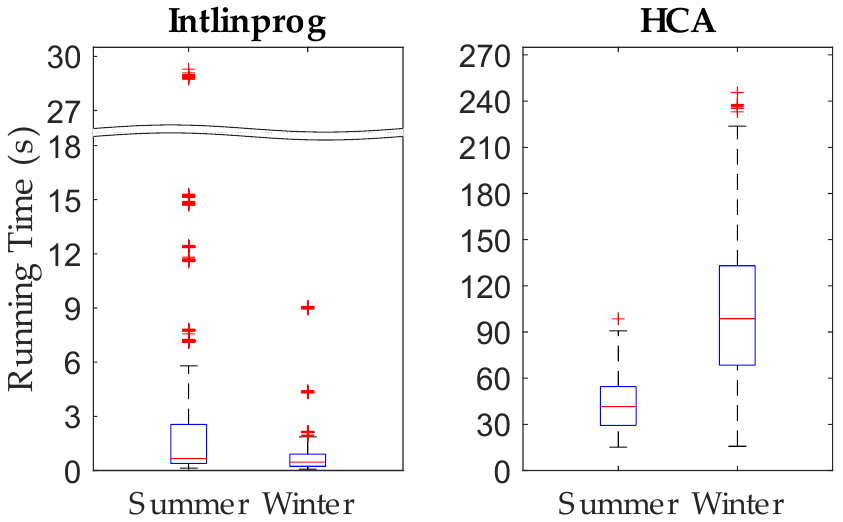
Figure 5. Running time durations of optimisation solvers intlinprog and the HCA registered when repeating winter and summer simulations twenty times. These repetitions are necessary to determine running time variability due to computer processing hierarchy. This study is based on a 1-kW heat pump, 600-L domestic hot water tank and 3-kWp PV